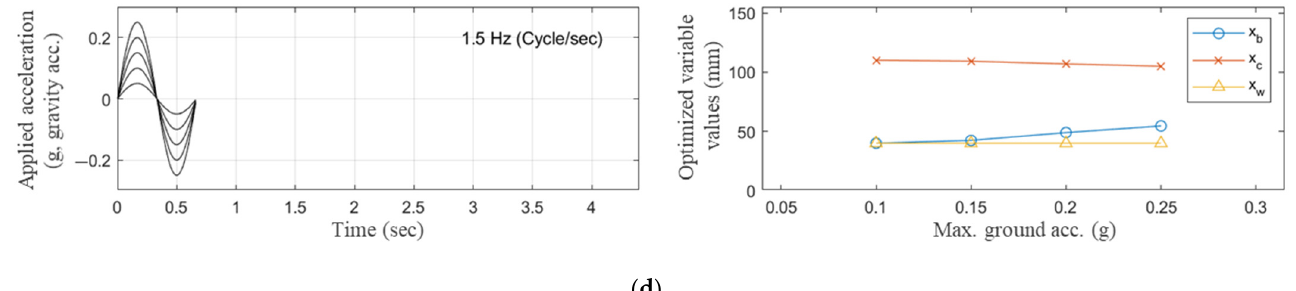
Figure 15. Dynamic optimization results with respect to the frequency of applied excitation: ( a ) 0.25 Hz ; ( b ) 0.5 Hz ; ( c ) 1 Hz ; and ( d ) 1.5 Hz .